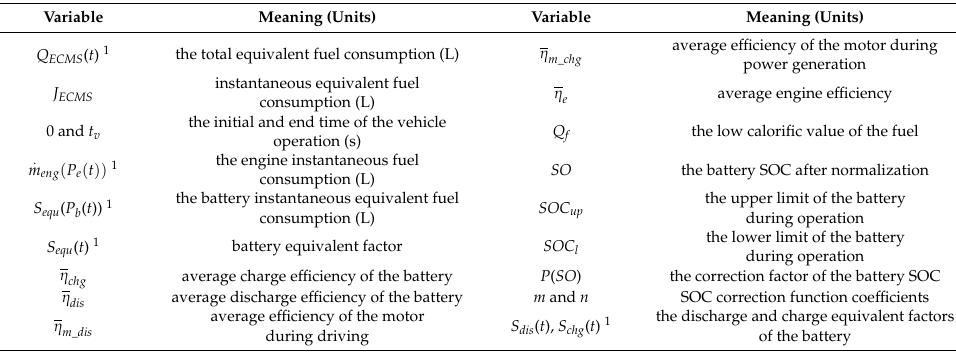
Table 6. Conventional ECMS model variables.